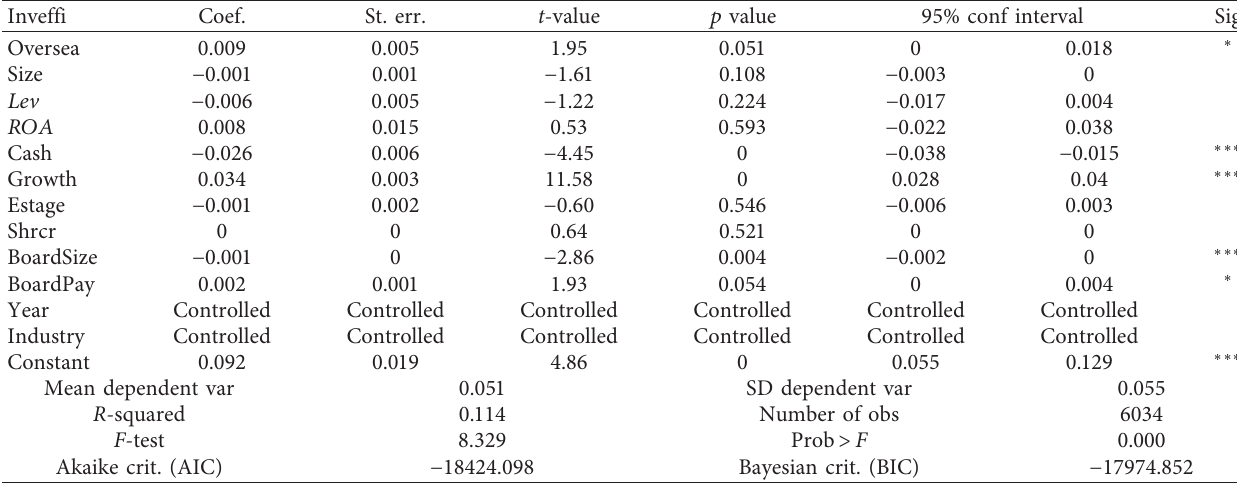
Table 7: Regression results of the relationship between overseas background of board members and investment efficiency of refinancing companies. Inveffi Coef.